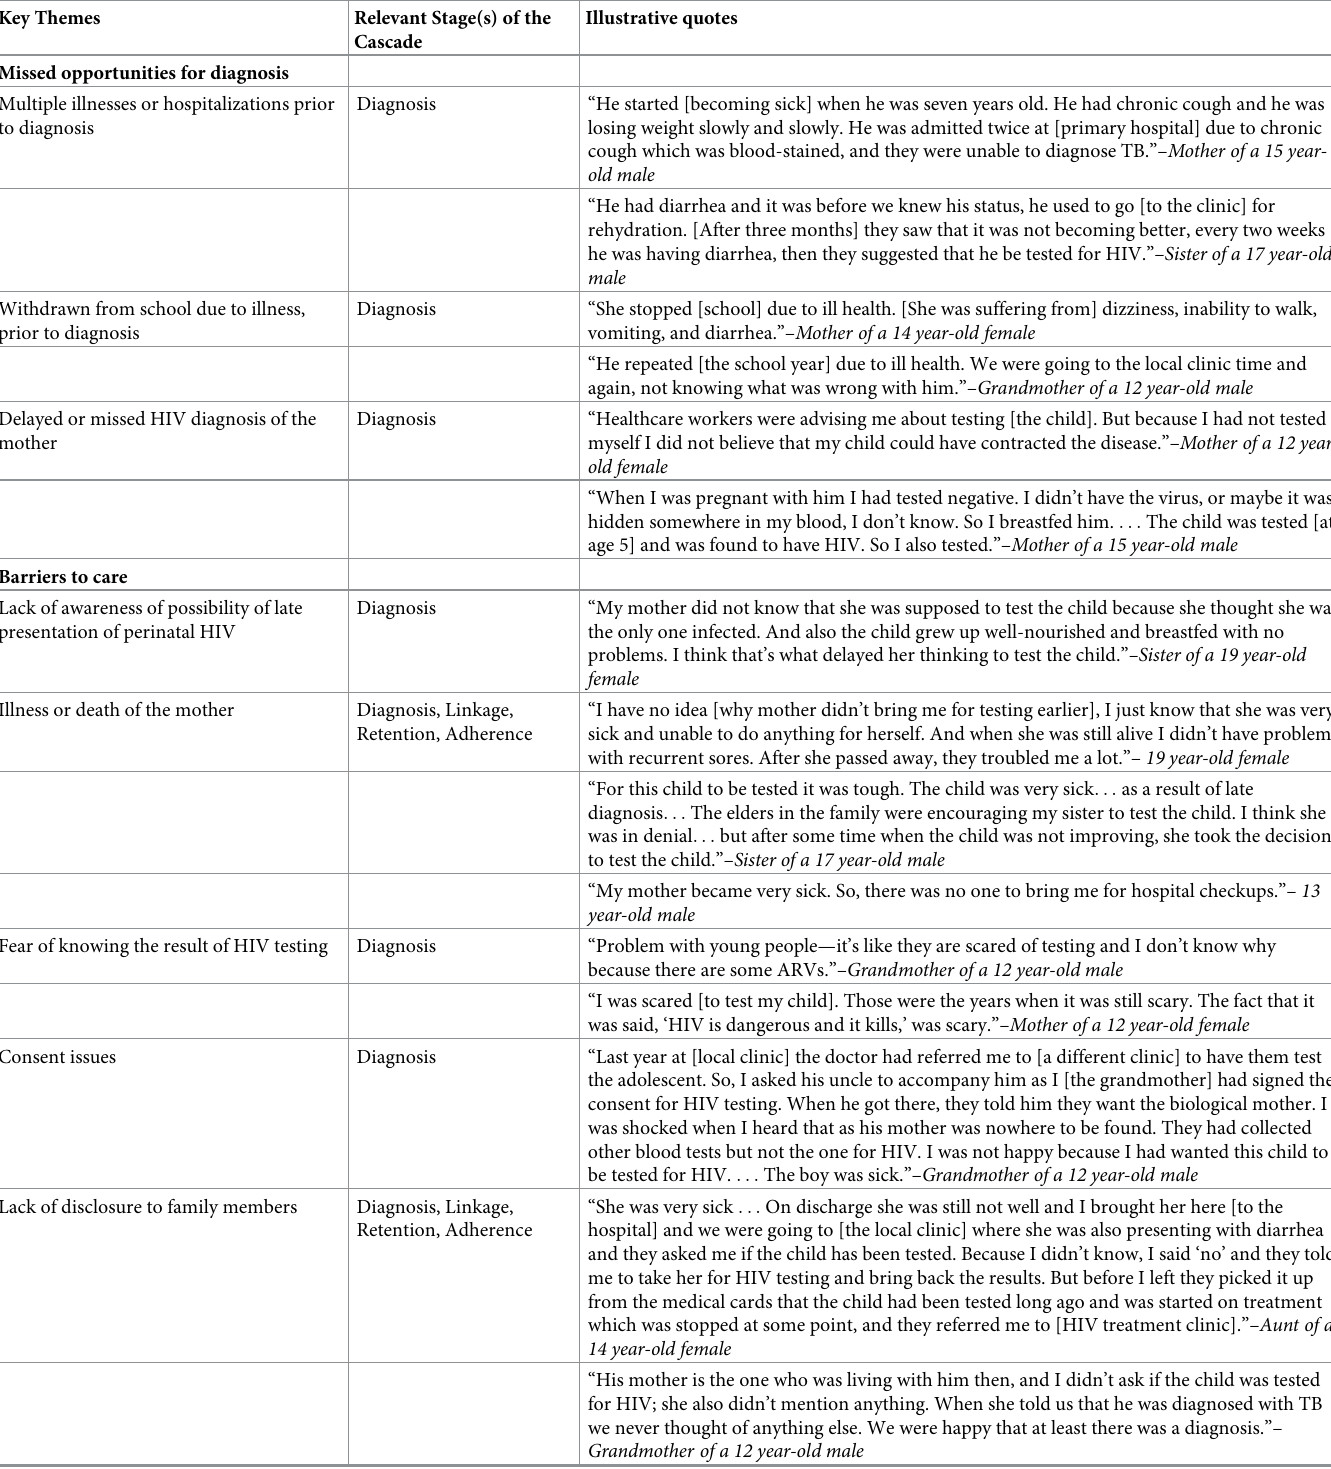
Table 4. Key themes relating to missed opportunities, barriers to care, and areas for intervention along the HIV care cascade a . Key